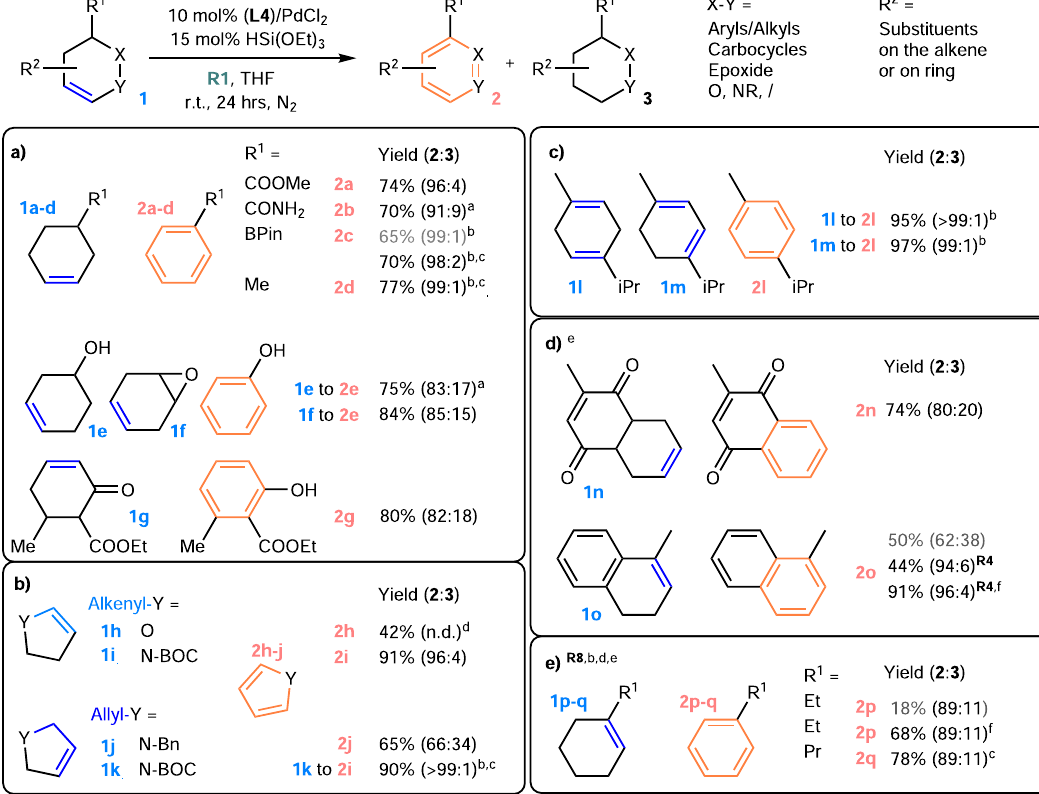
determined by 1 H NMR (average of two runs). a 48h; b as determined by GCMS (see theSupplementaryInformationfordetails); c thestandardconditionshowninFig.5 was used; d poor material balance due to a low b.p.; e conversion, 1o : 83; 47;